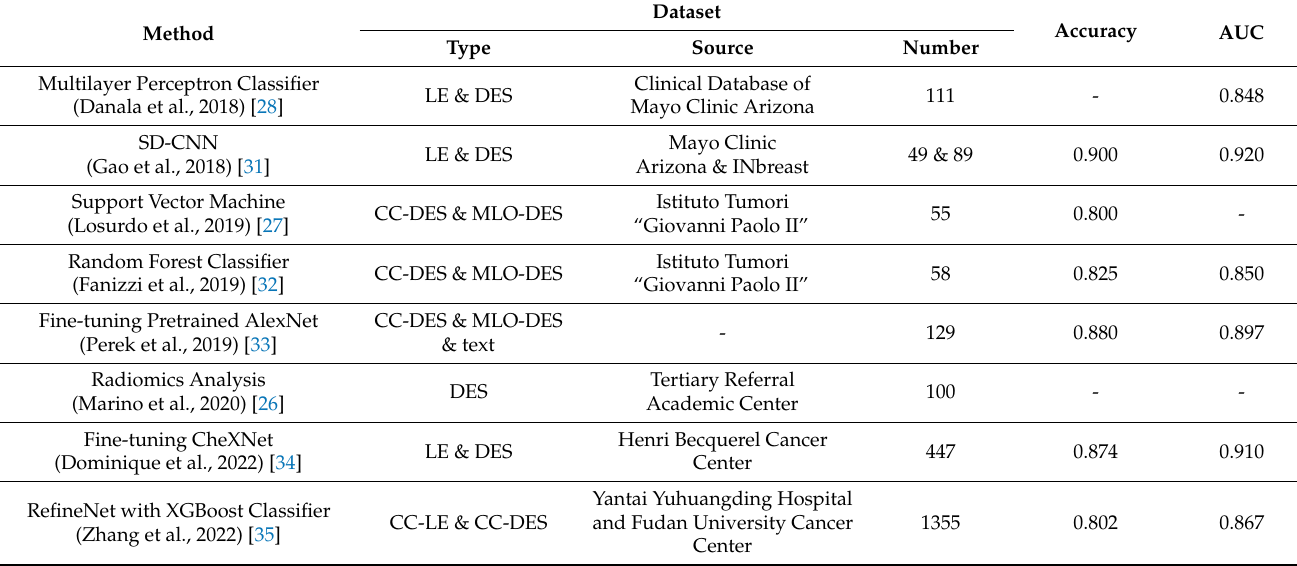
Table 1. Comparison between methods, datasets, and classification performance of CESM images in previous